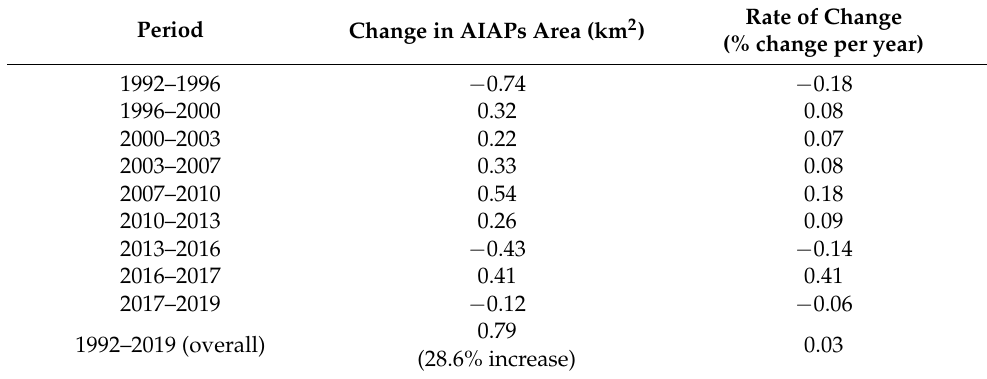
Table 6. The summary test results of Mann–Kendall and Sen’s slope test for annual average tem- perature and total annual rainfall time series.